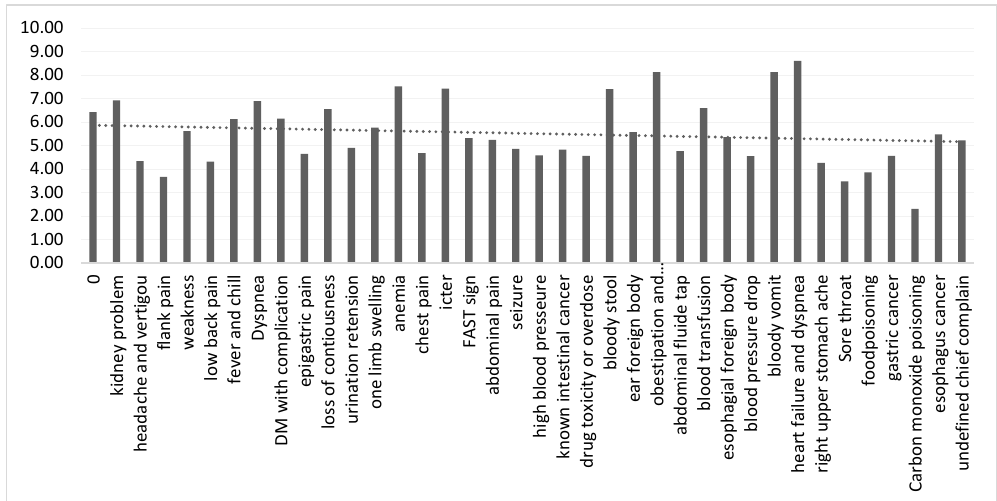
Figure 2. The average stay of the patients based on the main